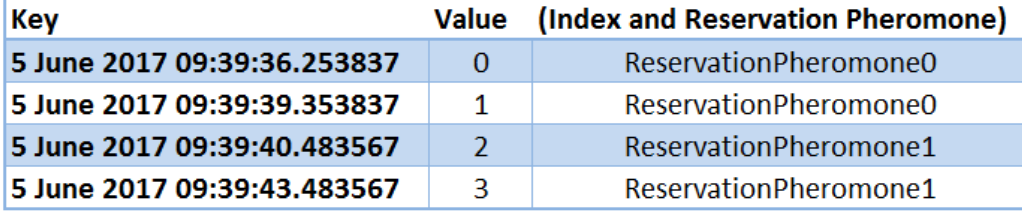
Figure 10. An illustration of keys and values of the intention binary search tree (BST).